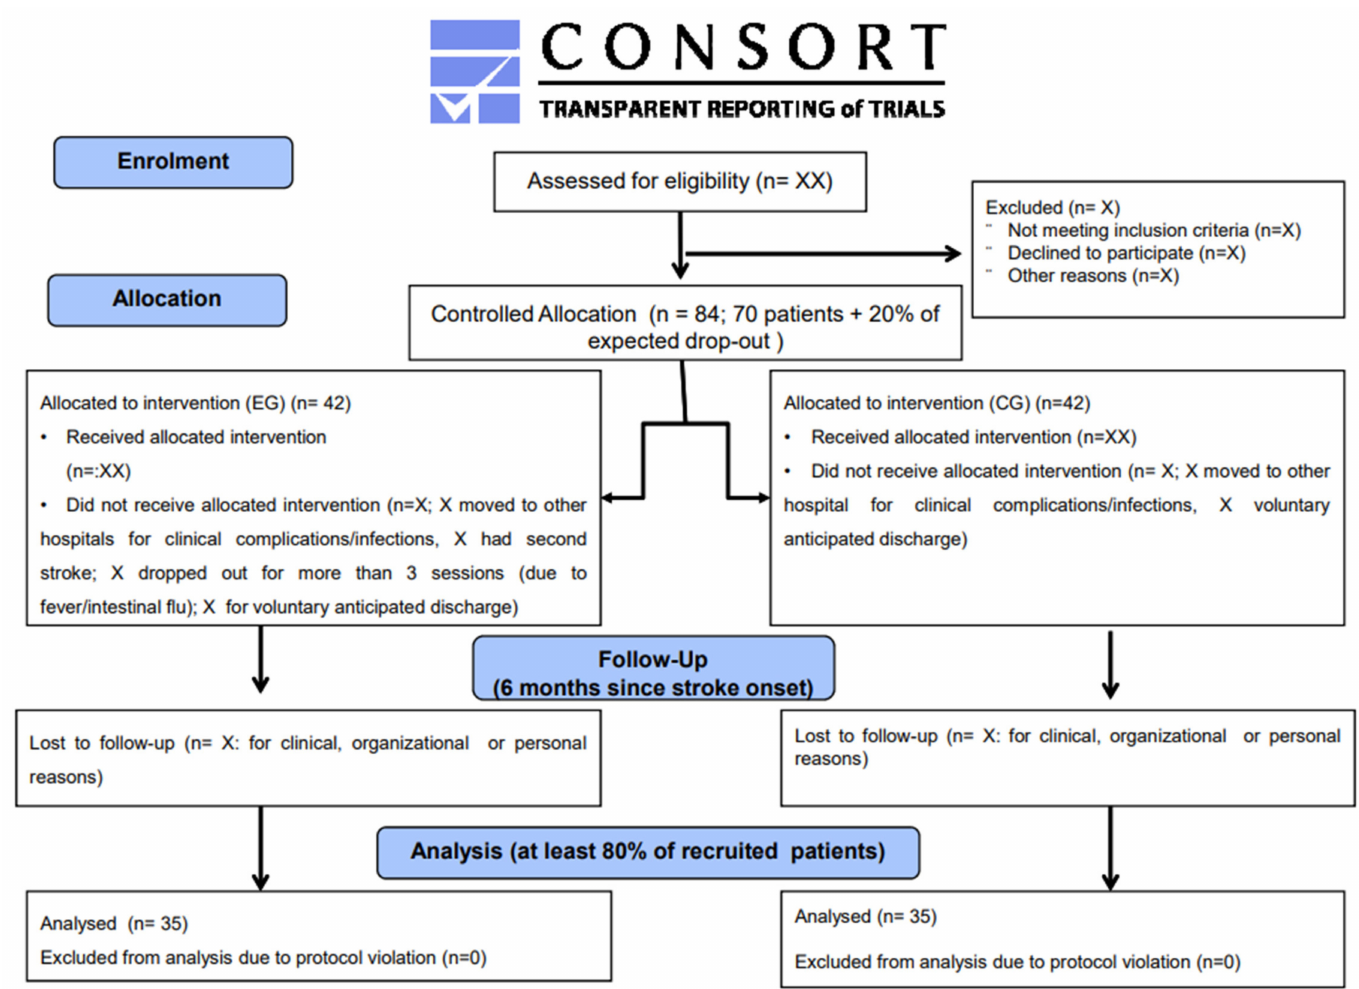
Figure 1. Consort flow